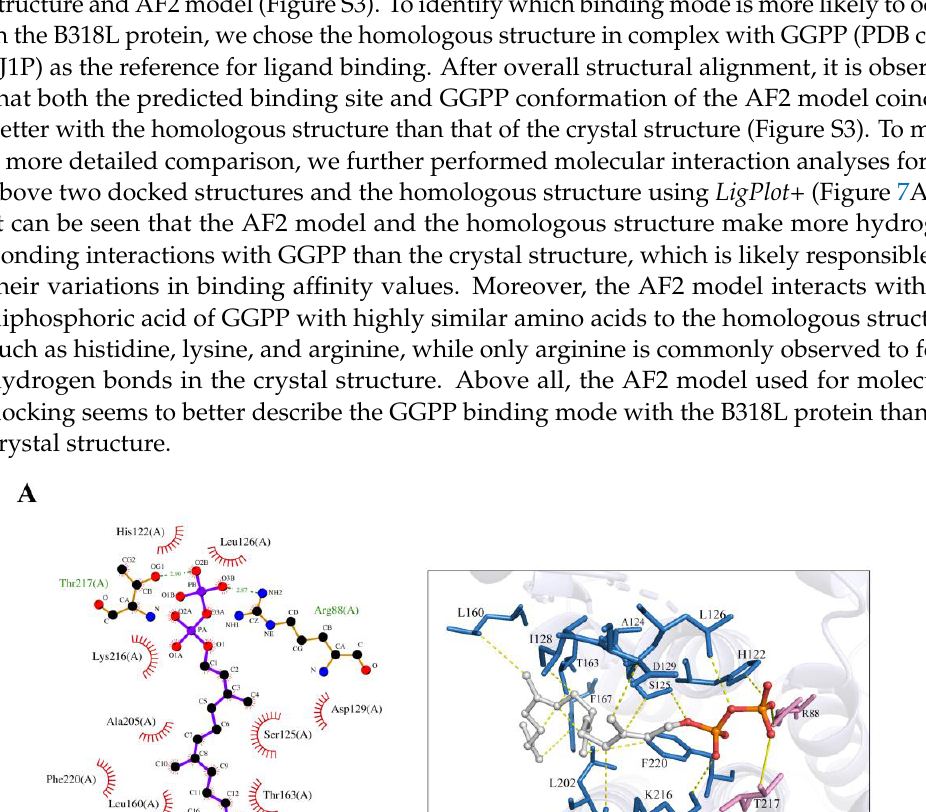
Figure 7. Schematic diagrams of the detailed interactions between the B318L protein and GGPP simulated with molecular docking. ( A – C ) Visualization of the detailed molecular interaction of GGPP with the B318L crystal structure ( A ), the AF2 predicted model ( B ), and the 2J1P homologous structure ( C ), respectively. In the left panels, all GGPP molecules and residues for hydrogen- bonding interactions are displayed as stick-ball models and the hydrogen bonds are marked by green dashed lines. All residues for hydrophobic interactions are also labeled and shown as eyebrow symbols. In the right panels, all GGPP molecules are displayed as stick-ball models in gray. Residues for hydrogen-bonding interactions are displayed as stick models in pink and the hydrogen bonds